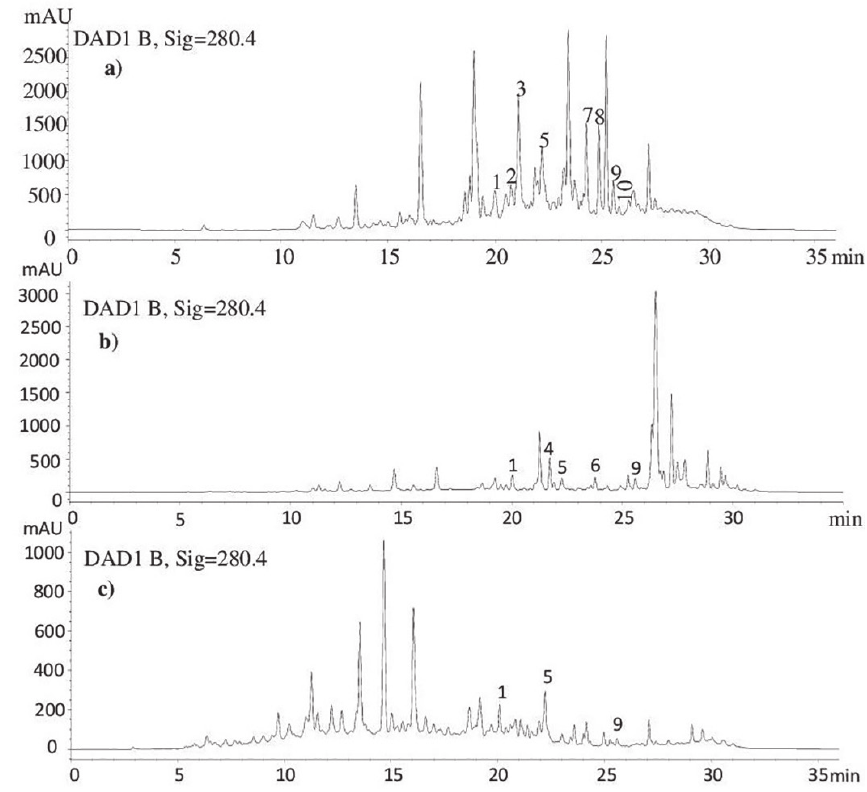
FIGURE 1 - Chromatographic profiles acquired at 280nm of poplar extracts. (a) Ethyl acetate fraction of P. nigra (AF.Pn). (b) methanolic extract of P. nigra (ME.Pn). (c) methanolic extract of P. alba (ME.Pa). Peaks numbers are referred to those reported in Table